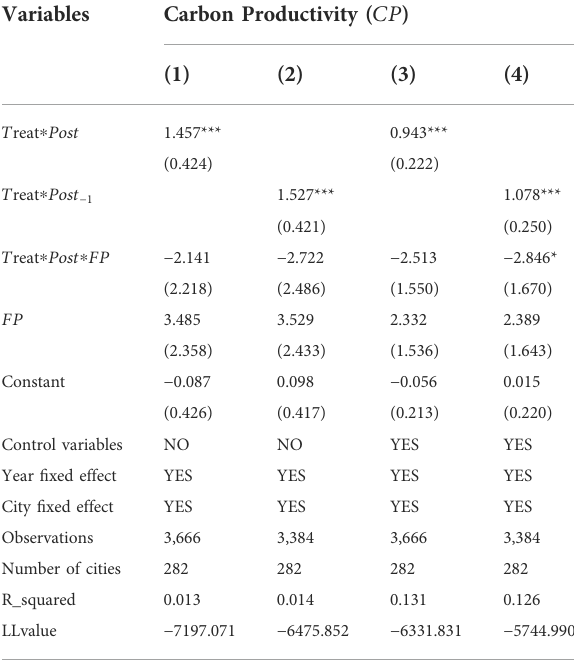
TABLE 6 Tobit-DID estimation